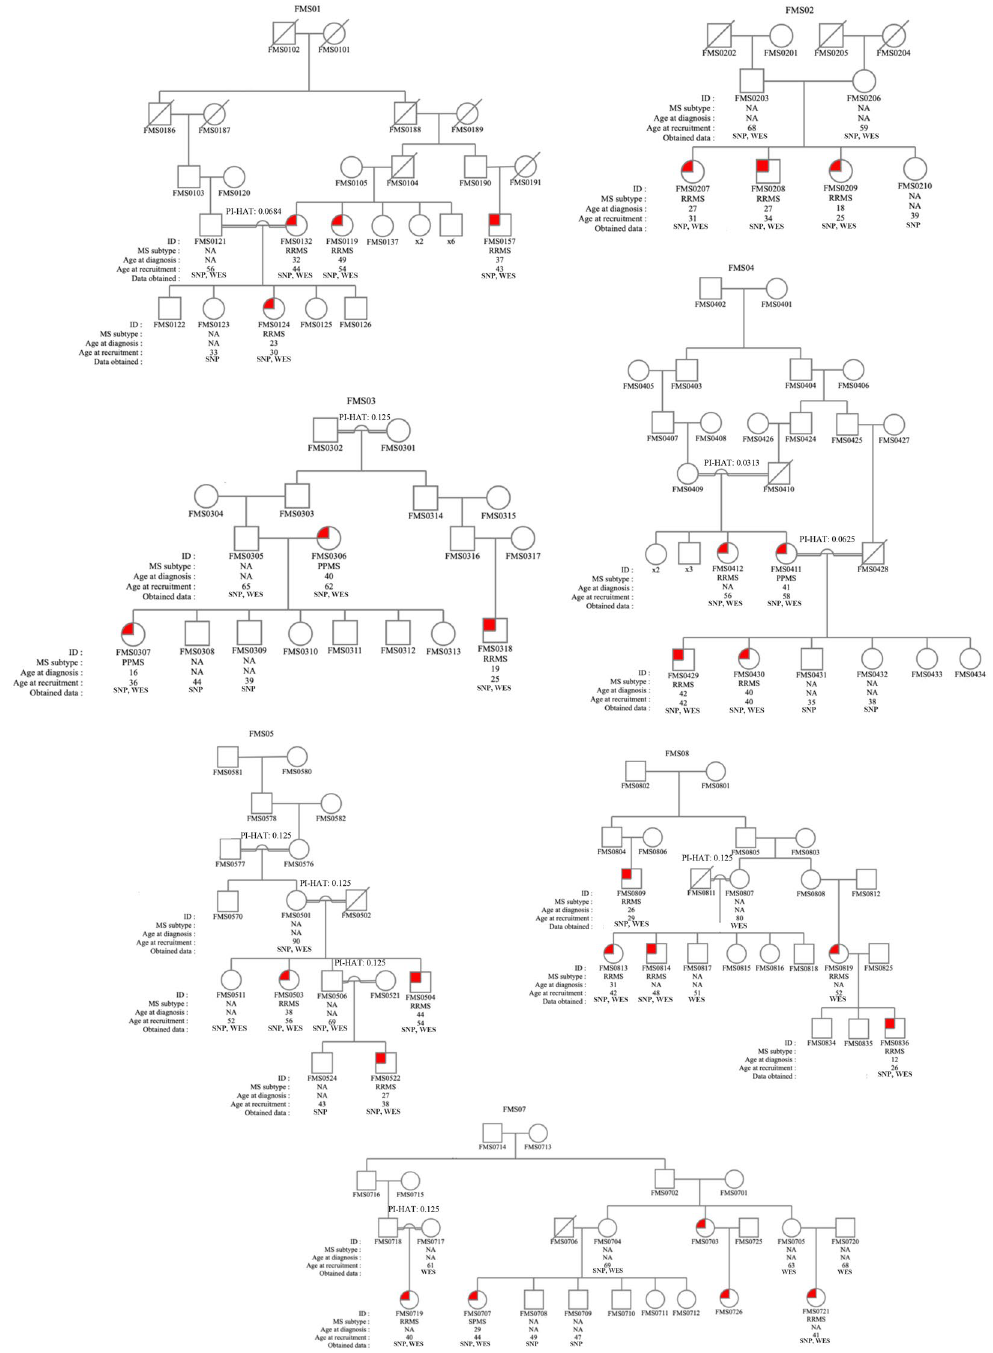
Figure 1. Simplified pedigrees of MS families included in the study. Males are represented by squares and females by circles. Diagonal line, deceased individual; red-colored symbol, clinically and magnetic resonance imaging-proven MS case; open symbol, non-MS relative. Individuals for whom SNP genotyping or exome sequencing was done are indicated with “SNP” and “WES,” respectively. Double line indicates consanguineous marriage, and relatedness degrees between these individuals are shown as PI-HAT values. PI-HAT for FMS0121 and FMS0132 was calculated using PLINK. Values for other consanguineous couples indicate the expected PI-HAT values based on the reported family relationships by the study participants. Pedigrees were constructed using the genetic data management system, Progeny Clinical—Web Version 9 from Progeny Genetics (Copyright 2019. Reprinted with permission of Progeny Genetics LLC, Delray Beach, FL, www. proge nygen etics. com). NA, not applicable; PPMS, primary progressive MS; RRMS, relapsing–remitting MS; SPMS, secondary progressive